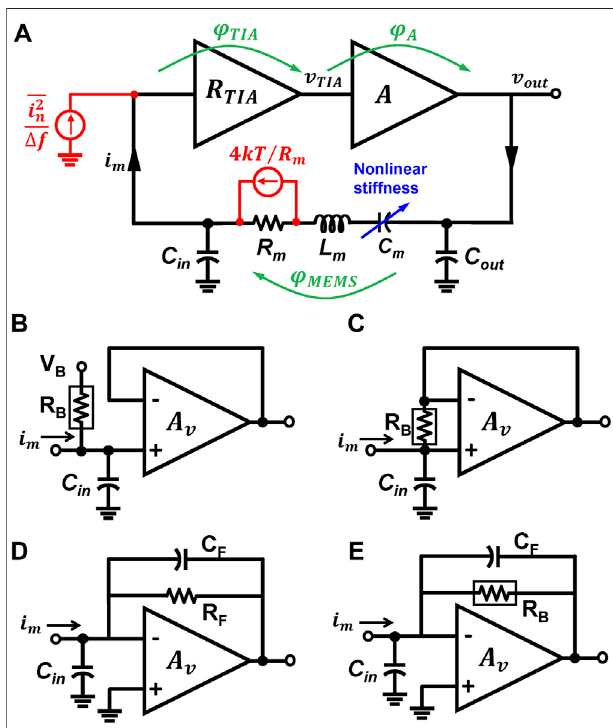
FIGURE1| CircuitarchitectureofageneralCMOS-MEMSoscillator: (A) overall oscillator circuit with noise sources; (B) voltage buffer as input stage; (C) voltagebufferwithfeedbackbiasingtechniqueasinputstage; (D) resistive feedback transimpedance ampli fi er (R-TIA) as input stage; (E) charge integrator (CI) as input stage.